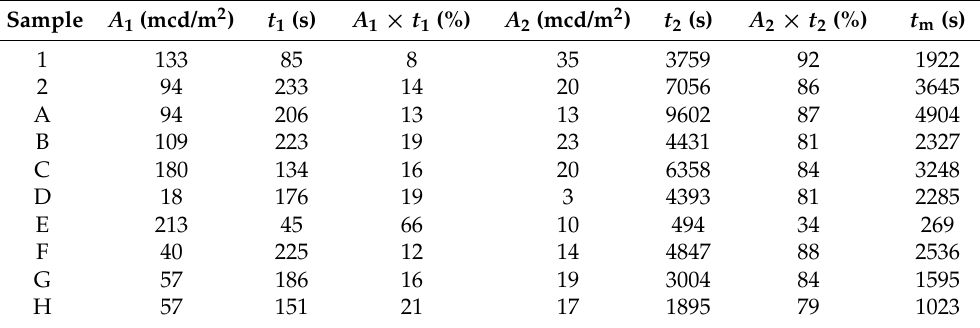
Table 2. Luminescence kinetic analysis results.